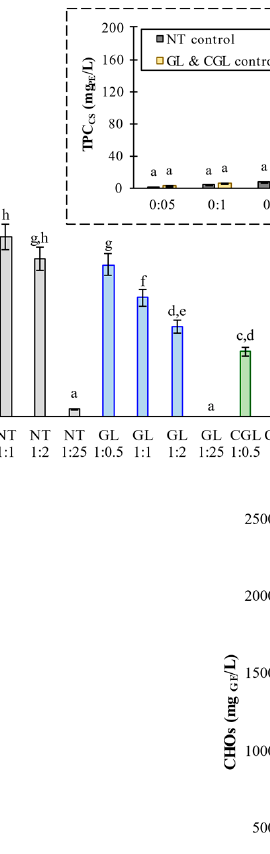
Figure 2. TPC values ( A ), sorption yields, Y P ( B ), and CHOs values ( C ) of AF ( ), CS (native ( ), and gelled ( )) control samples and AF–CS blending methods of NT ( ), GL ( ), and CGL ( ) samples. NT method: AF (seaweeds flour) and native corn starch (CS) blending; GL method: AF and gelled CS blending; CGL method: CS gelatinized in the presence of AF. Different letters indicate significant ( p < 0.05) differences among samples.